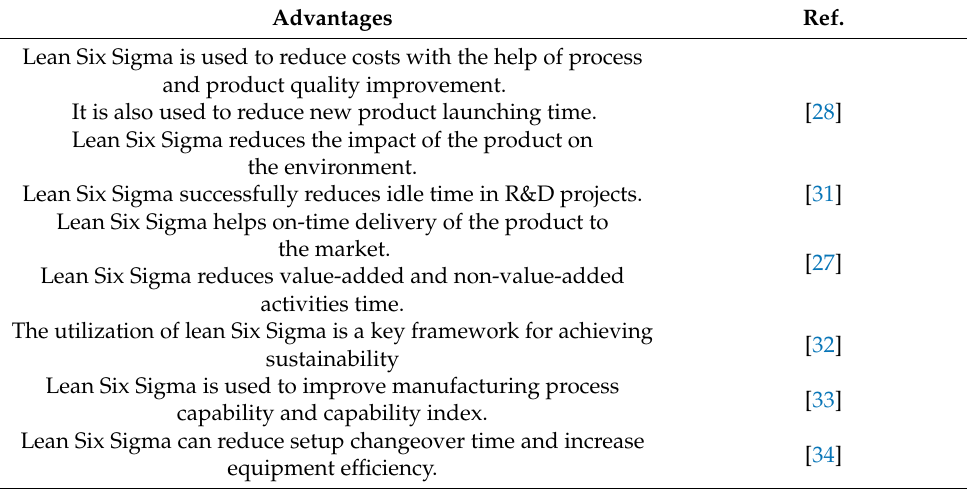
Table 3. Lean six sigma and its outcome. Advantages